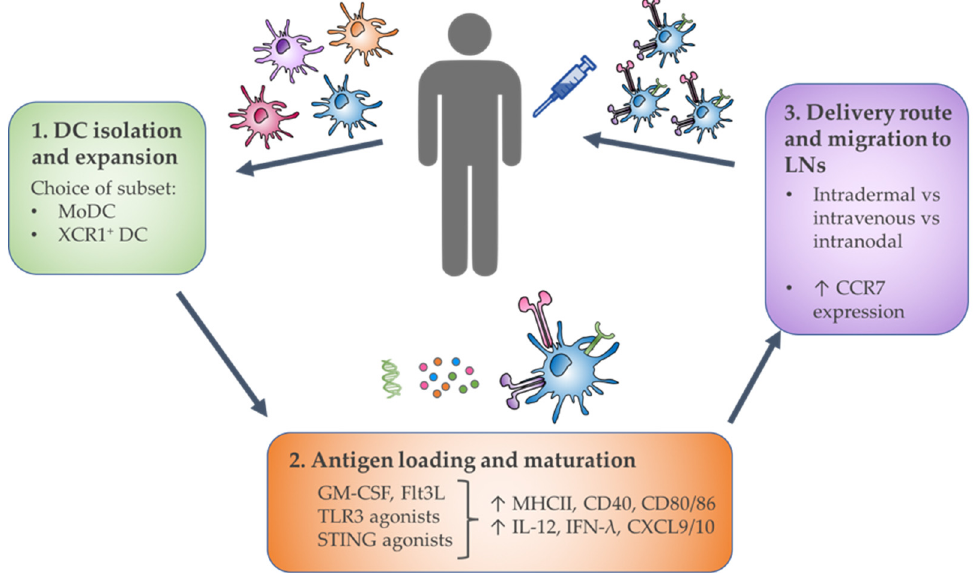
Figure 1. Critical considerations for DC vaccination. DCs may be isolated from patients or generated in vitro. New protocols designed to specifically generate large amounts of XCR1 + DCs, rather than MoDCs, may prove beneficial. Ex vivo culture with cytokines and/or TLR/STING agonists upregulates maturation markers on antigen-loaded DCs, and increases cytokine and chemokine secretion. Activated XCR1 + DCs are typically injected intradermally, although intranodal improves efficiency of DCs reaching the LNs. Upregulation of CCR7 expression aids in DC migration to the LNs, where they cross-present pre-loaded antigen to naïve CD8 + T cells. Cells 2020 , 9 , 565